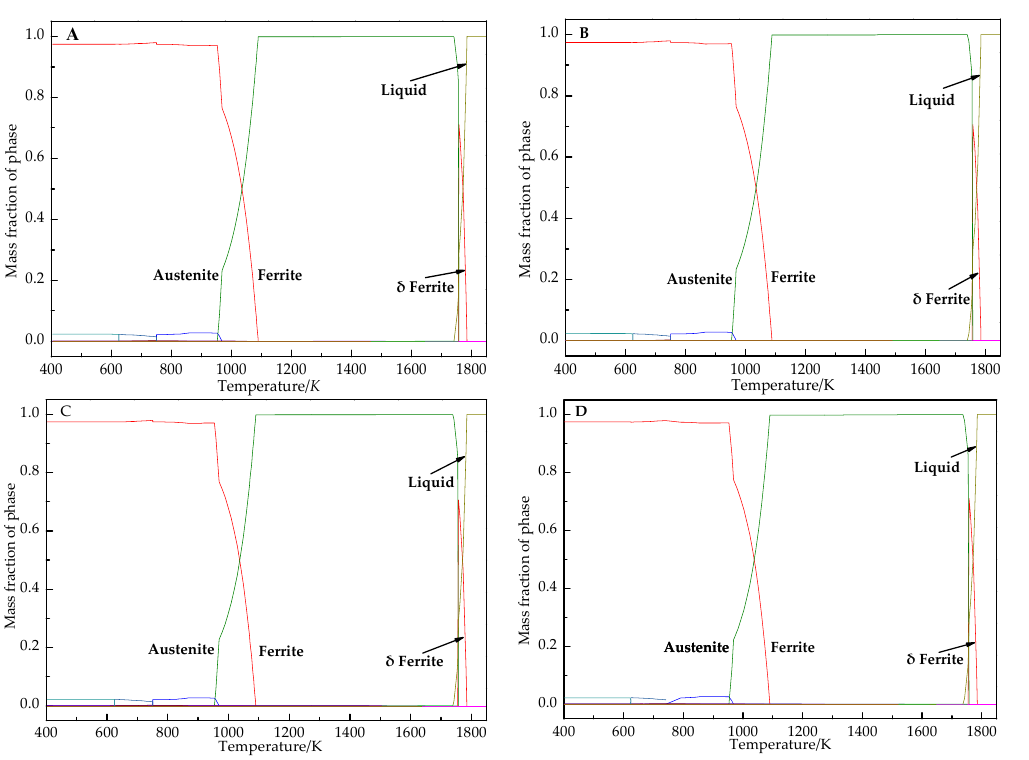
Figure 3. Equilibrium phase diagram of Q355GJ steel with different Nb contents. (( A – D ) represent four different Nb content test steels respectively).